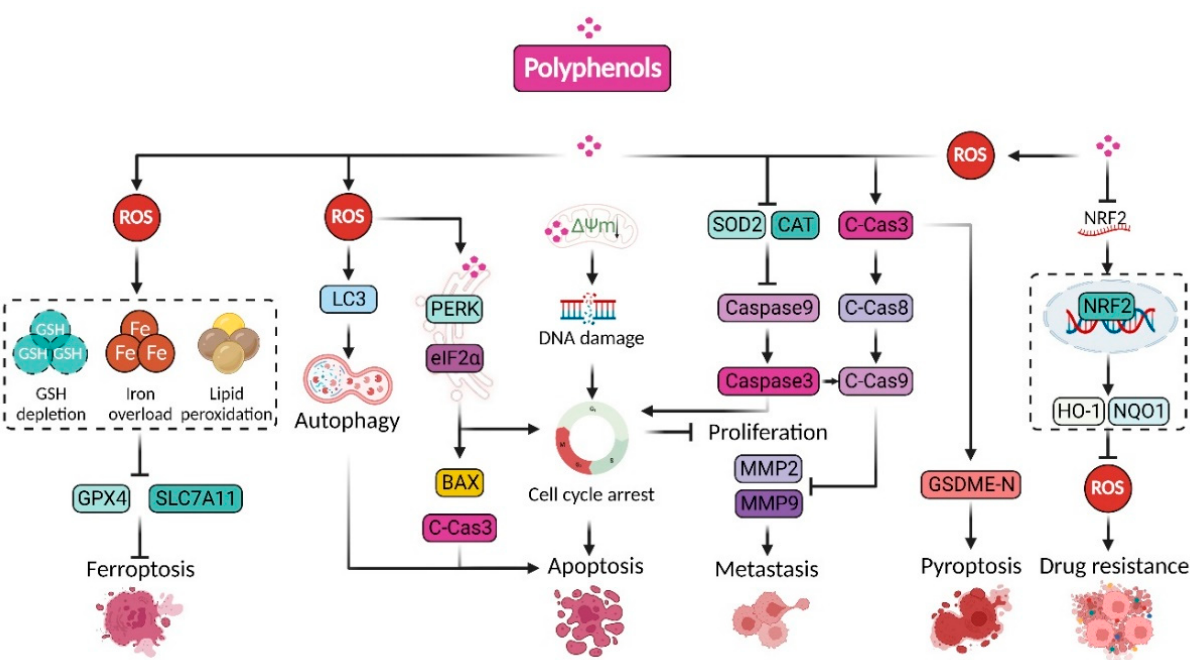
Figure 4. Prooxidant roles of polyphenols in cancer therapy. Typically, polyphenols induce glu- tathione (GSH) depletion, iron overload, lipid peroxidation, autophagosome augmentation, and caspase3 cleavage to trigger programmed death of cancer cells, including ferroptosis, autophagy, apoptosis, and pyroptosis. Moreover, polyphenols evoke endoplasmic reticulum (ER) stress and decrease in mitochondrial membrane potential, which could also induce cell death. On the other hand, polyphenol-induced ROS are capable of cleaving caspase3/8 9 and impairing the activities of MMP2/9, thus suppressing metastasis of cancer cell. In addition, polyphenols could inhibit the transcriptional activity of NRF2 to improve the sensitivity of cancer cells to